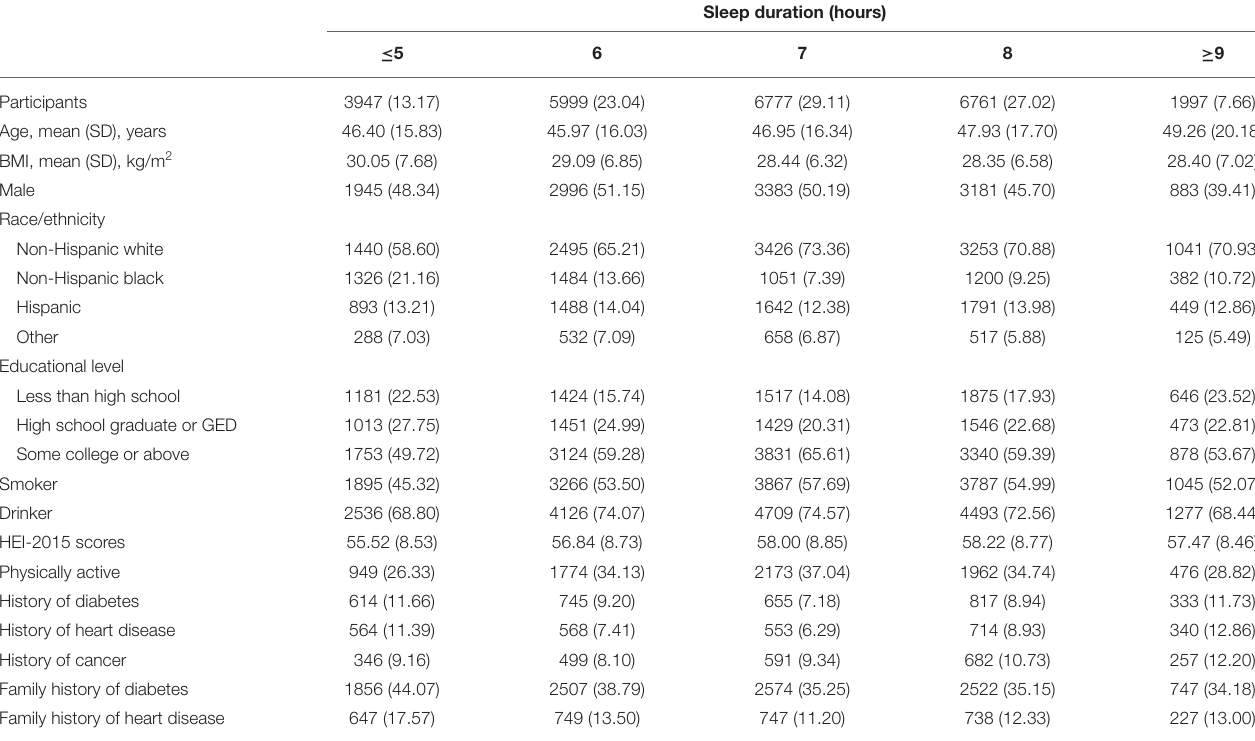
TABLE 1 | Characteristics of study participants by categories of sleep duration * .